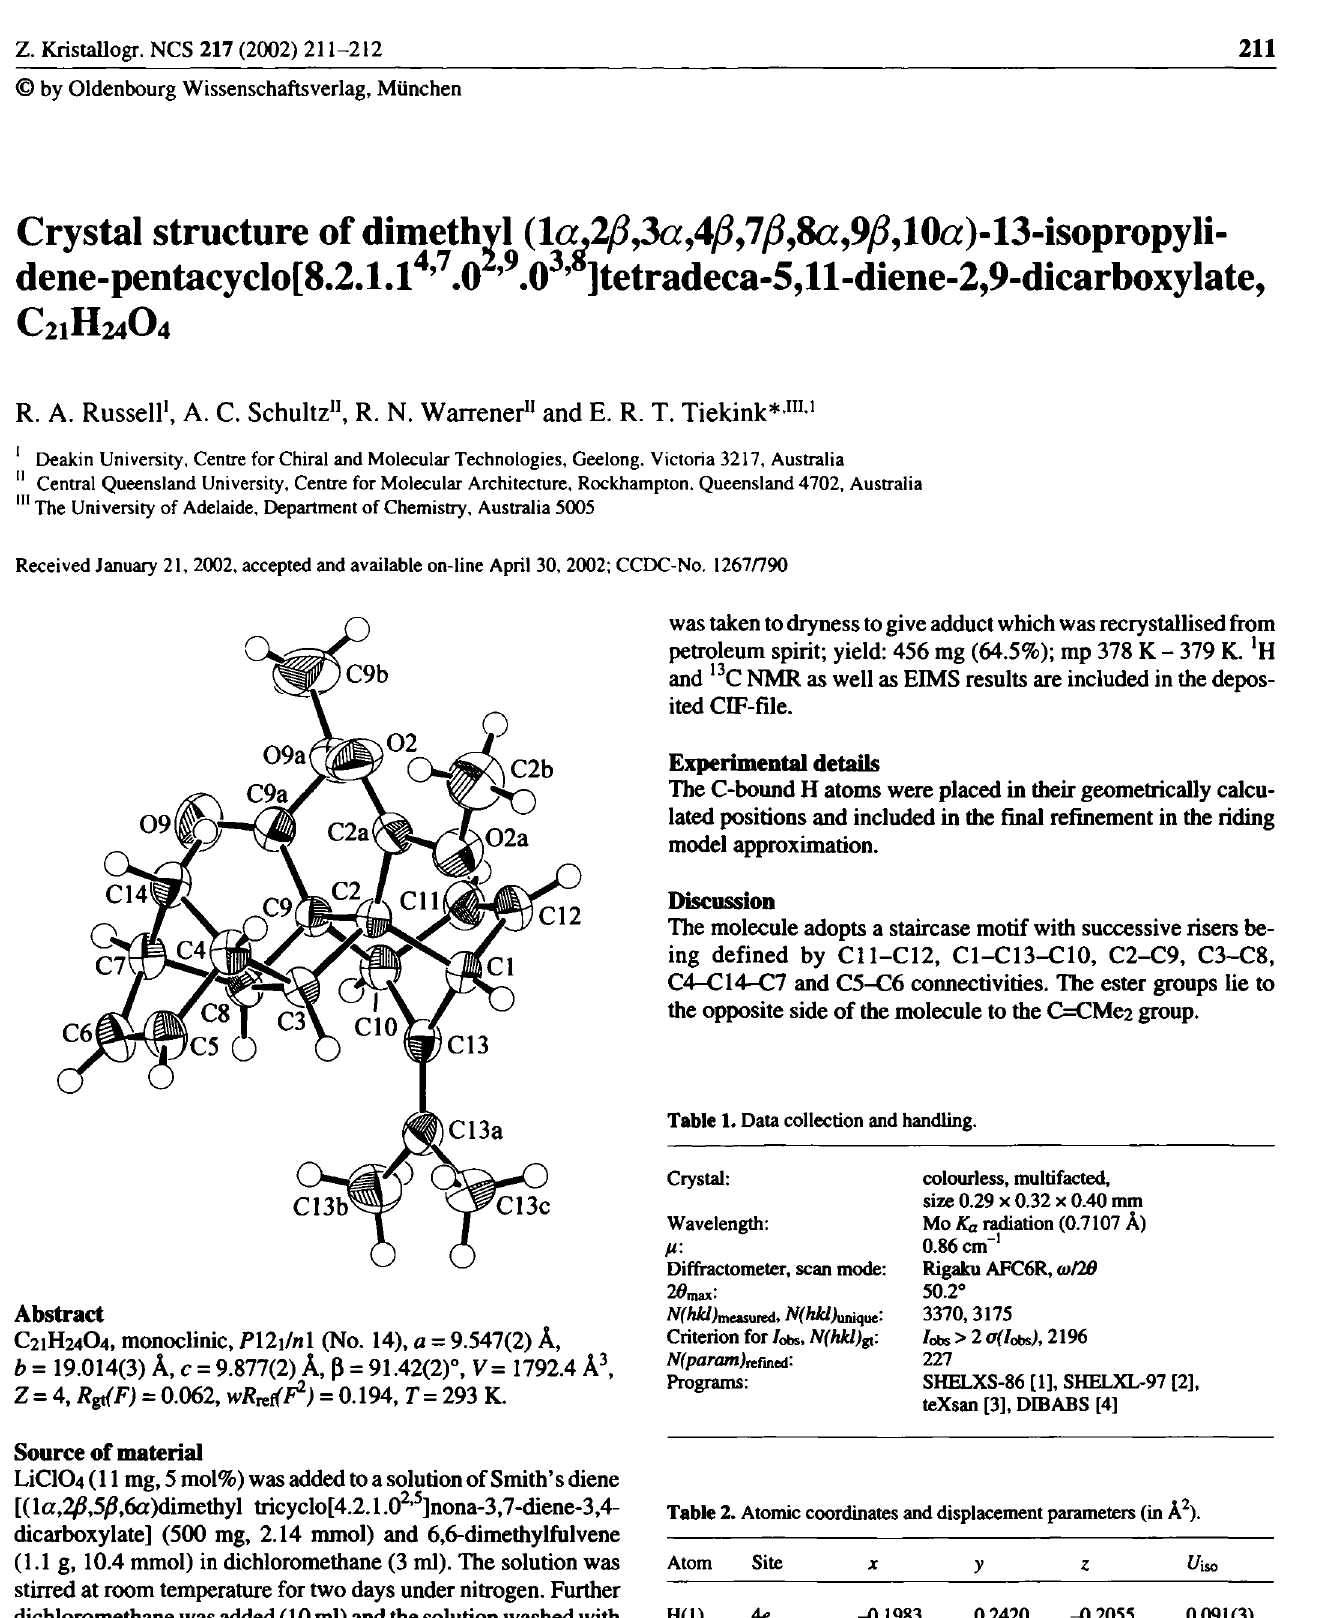
Table 2. Atomic coordinates and displacement parameters (in Â 2